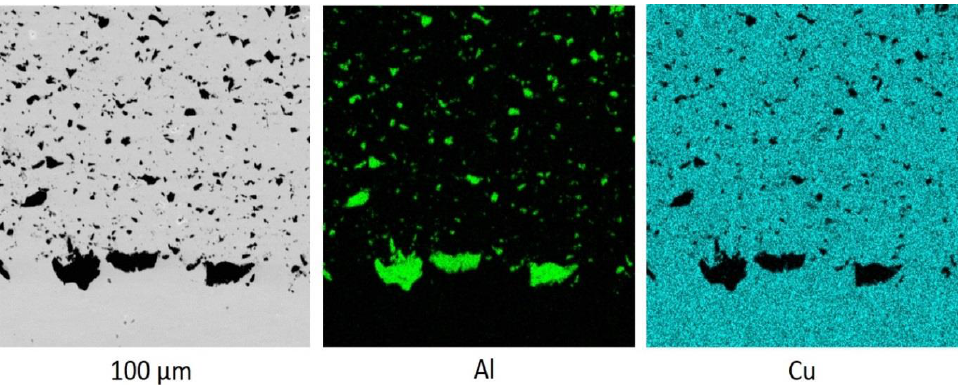
Figure 5. Coarse alumina particles embedded locally in the substrate surface for the cold-sprayed Cu-60% Al 2 O 3 coating with preprocessing and distribution maps of elements.